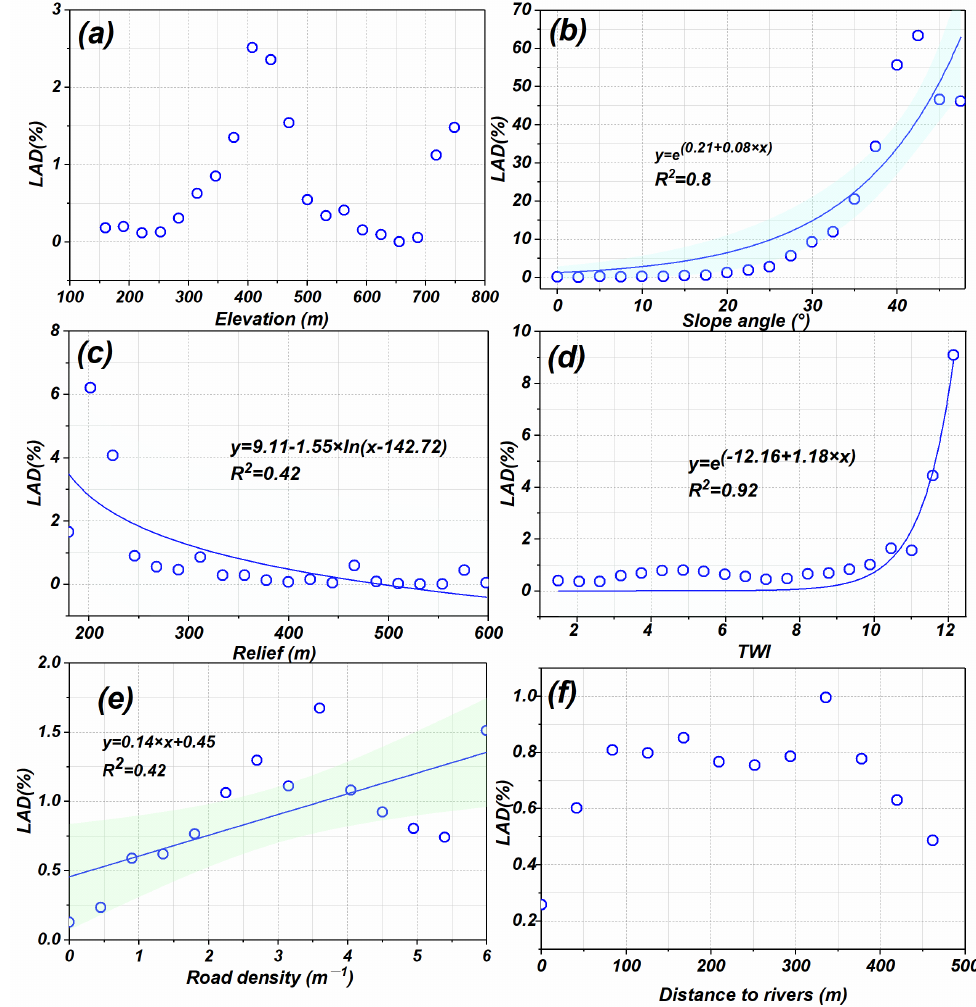
Figure 14. Map showing the relationship between the six influencing factors and the landslide areal density (LAD); ( a ) elevation; ( b ) slope angle; ( c ) topographic relief; ( d ) TWI; ( e ) road density; ( f ) distance to rivers.